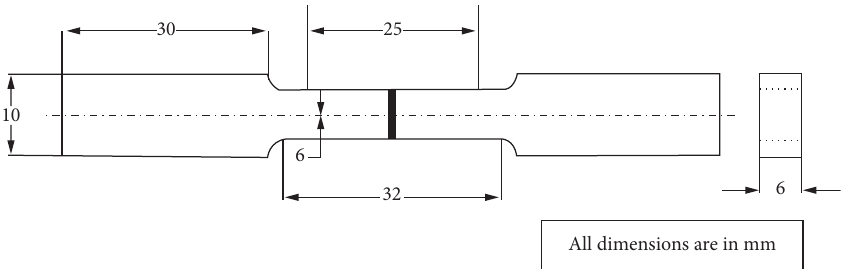
Figure 12: Experimental flow chart.